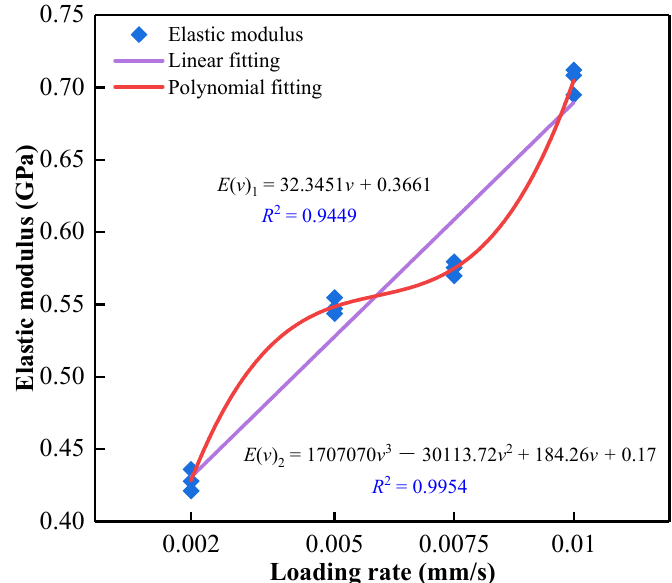
Figure 5. Relationship between elastic modulus and loading rate.